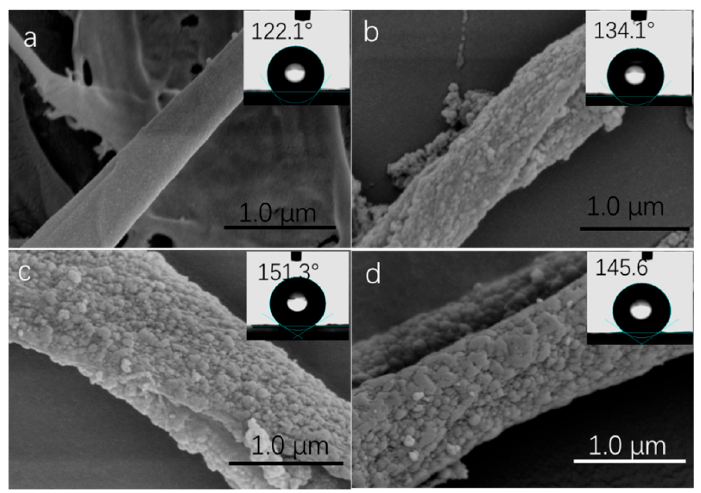
Figure 4. SEM images of raw cellulose fibers ( a ) and cellulose fibers catalyzed with different amount of ammonia: ( b ) 1 mL, ( c ) 2 mL, ( d ) 3 mL.